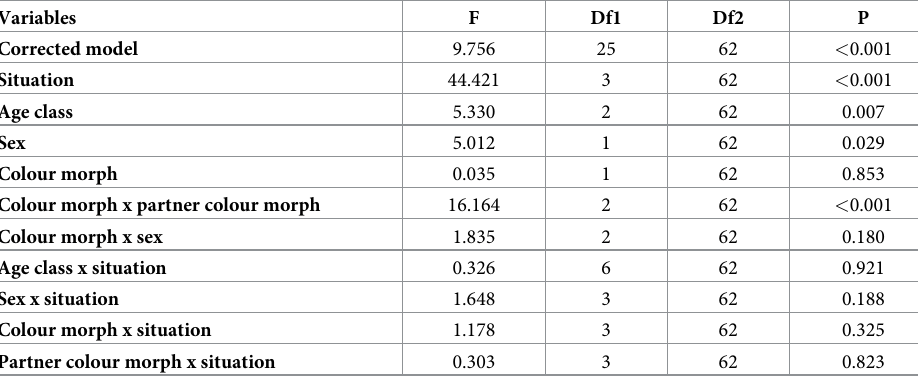
Table 2. General Linear Mixed Model outcome of best model (see Table 1).